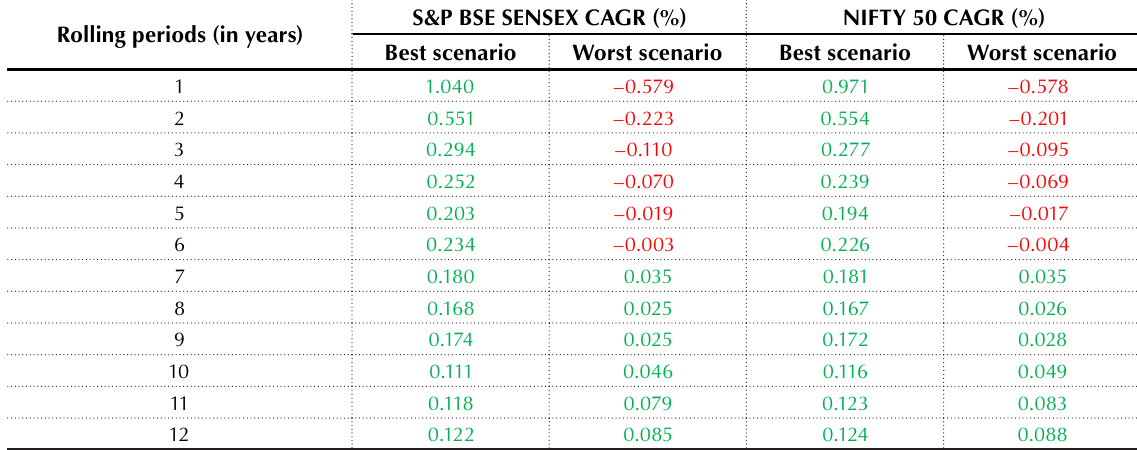
Table 10. Rolling period CAGR (in %) for market indices S&P BSE SENSEX and NIFTY 50 (from 2006 to